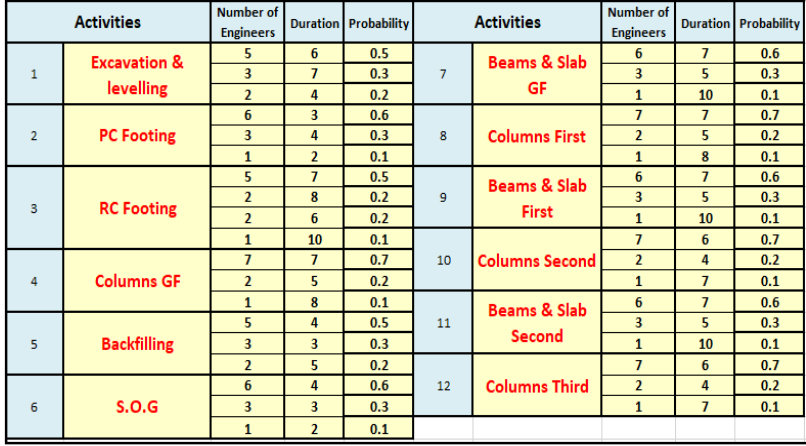
Figure 12. Analysis of the survey results.